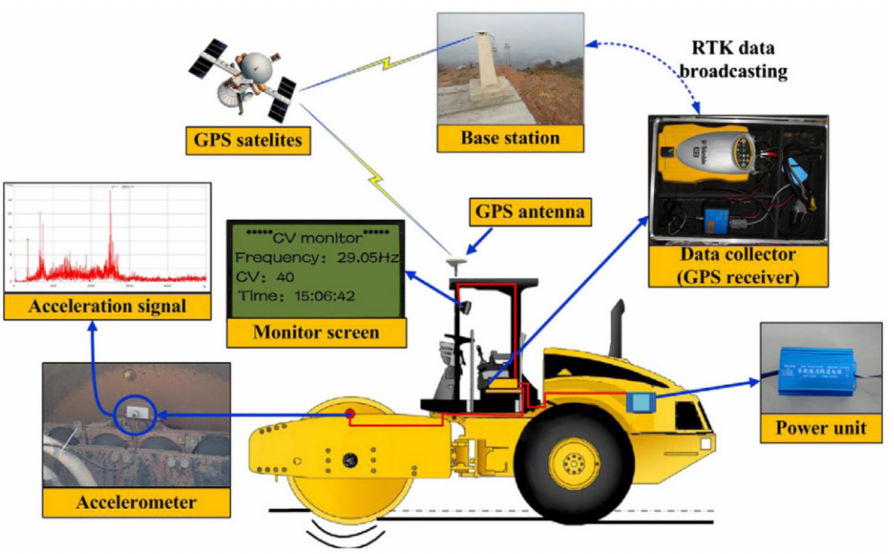
Figure 8. Installation of the roller-integrated compaction status monitoring device (reprinted with permission from Reference [24], copyright Elsevier,